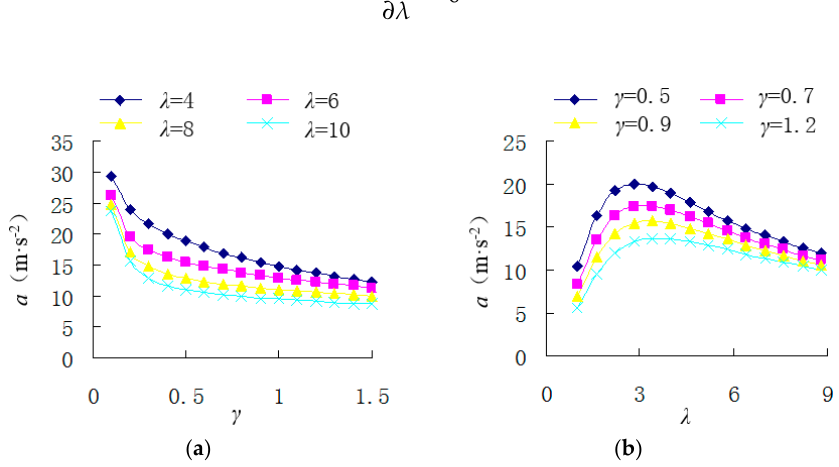
Figure 9. Acceleration versus parameters γ and λ : ( a ) with different λ ; ( b ) with different γ .